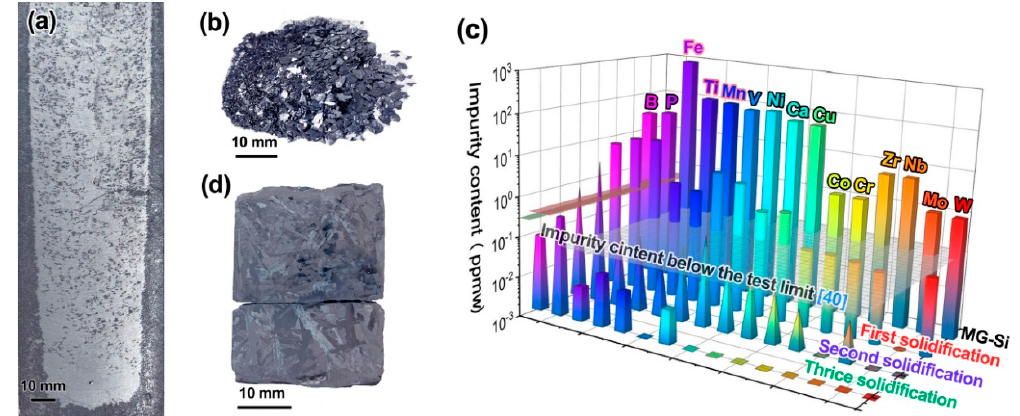
Figure 10. ( a ) Vertical section of Al-30Si alloy prepared by the continuous separation technique, ( b ) image of the collected primary Si particles, ( c ) impurity contents in the primary Si after each solidification purifying, ( d ) poly-crystalline Si ingot.